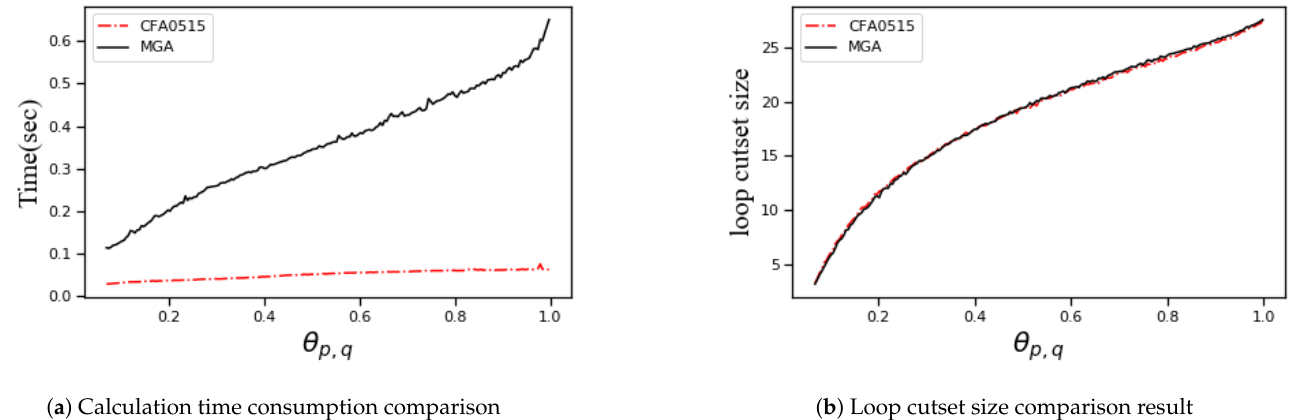
Figure 5. Randomly generate Bayesian networks with 30 nodes and gradually increasing the number of edges, apply the CFA and the MGA to the Bayesian networks,